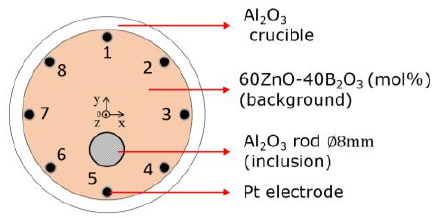
Figure 6. Experimental condition.